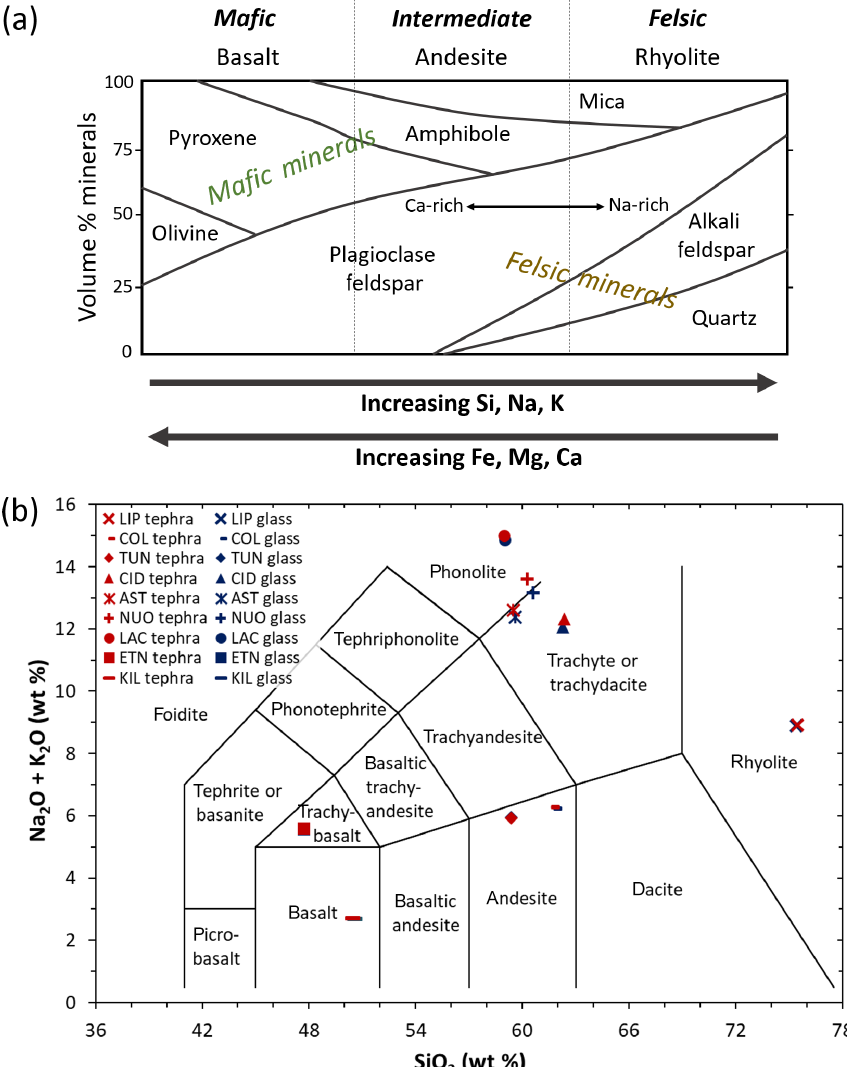
Figure 1. (a) Schematic summarizing the mineralogy of common igneous rock types. Modified after Rogers (2015). (b) Total alkali versus silica diagram showing the classification of the tephra (red symbols) and glass (blue symbols) used in this study. Sample codes are listed in Table 1. Modified after Le Maitre et al.